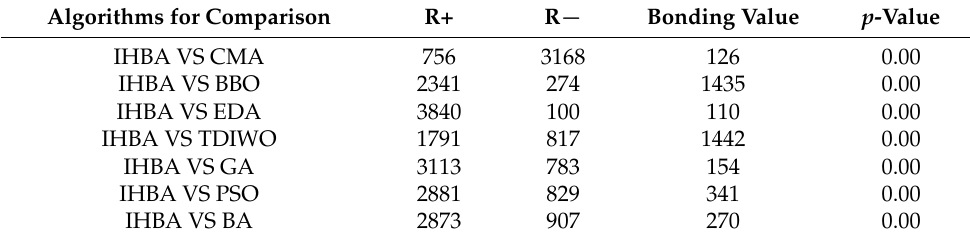
Table 6. The Wilcoxon paired signed test result at C = 20 and α = 0.05. Algorithms for